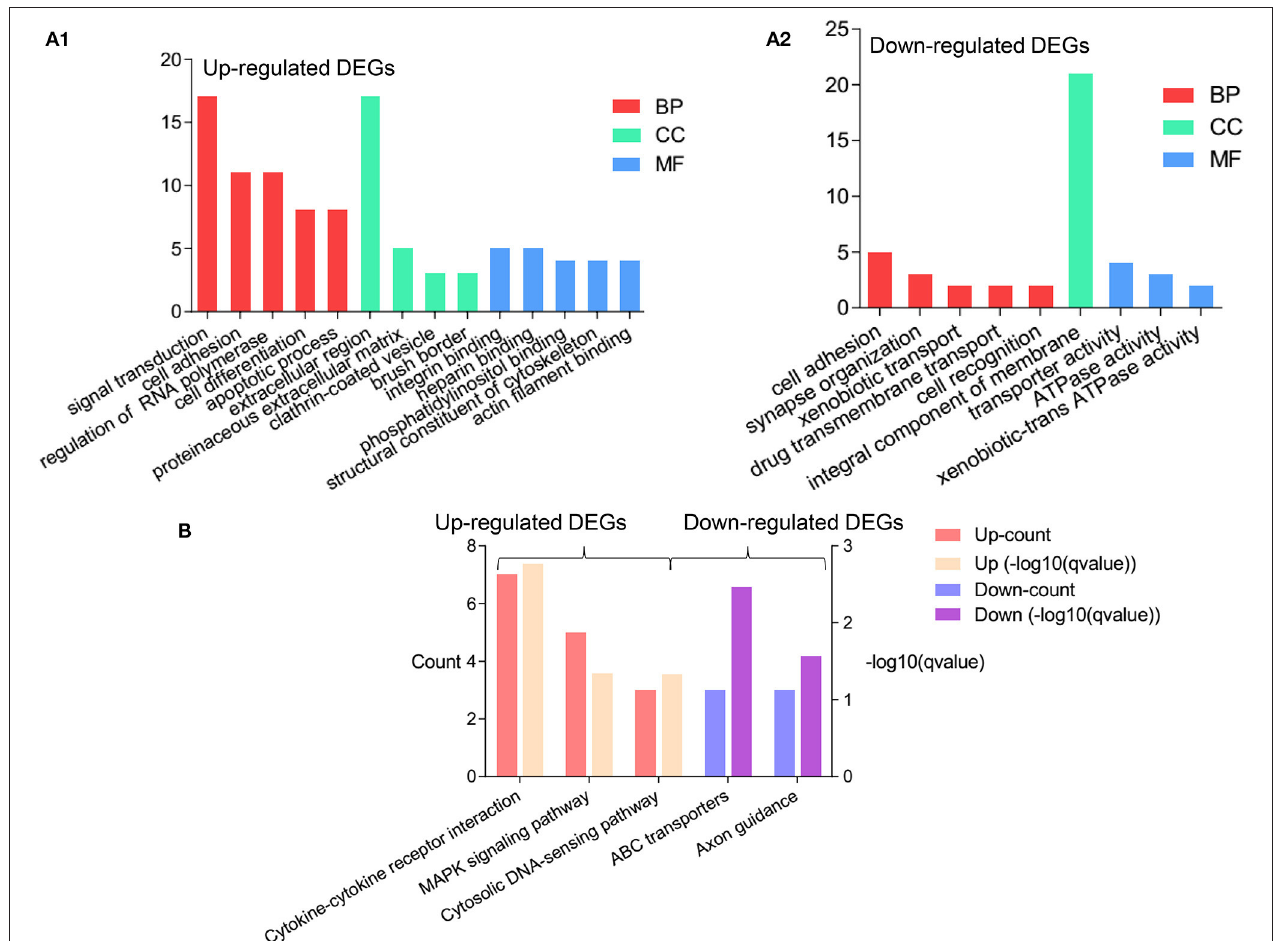
FIGURE 2 | The significant results of enrichment analysis from the Database for Annotation, Visualization, and Integrated Discovery (DAVID) website. The cutoff criterion was P < 0.05. (A1) The GO functional enrichment analysis of the upregulated DEGs (log 2 FC > 1) based on the three types of sub-ontologies (Biological Processes: top two terms; Molecular Function: four terms; Cellular Component: top five terms); ordinate axis represents the number of DEGs under the GO term. (A2) The GO functional enrichment analysis of the upregulated DEGs (log 2 FC > 1) based on the three types of sub-ontologies (Biological Processes: top five terms; Molecular Function: one term; Cellular Component: three terms); ordinate axis represents the number of DEGs under the GO term. (B) The enrichment of the KEGG pathway analysis of the upregulated DEGs (left) in the AV fistula group compared with the control group and the downregulated DEGs (right) in the AV fistula group compared with the control group; ordinate axis at left represents the count of DEGs under the KEGG pathway term and ordinate axis at right represents the q -value of DEGs under the KEGG pathway term. DEGs, differentially expressed genes; GO, Gene